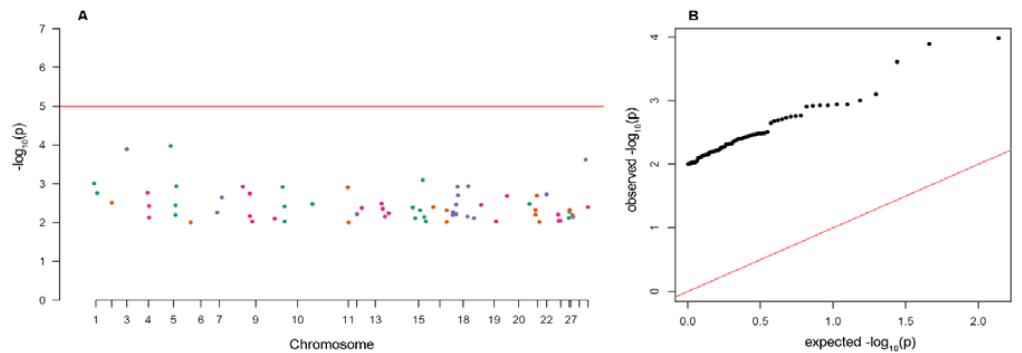
Figure 5. Manhattan ( A ) and Q ‐ Q plot ( B ) builds for 86 putative outlier loci detected with the Arlequin and Bayescan methods: Each dot on this figure corresponds to a SNP within the dataset, while the horizontal red line denotes the genome ‐ wide significance. The Manhattan plot contains − log10 observed p ‐ values for putative outlier SNPs (y ‐ axis) plotted against their corresponding position on each chromosome (x ‐ axis), while the Q ‐ Q plot contains expected − log10 ‐ transformed p ‐ values plotted against observed − log10 ‐ transformed p ‐ values.